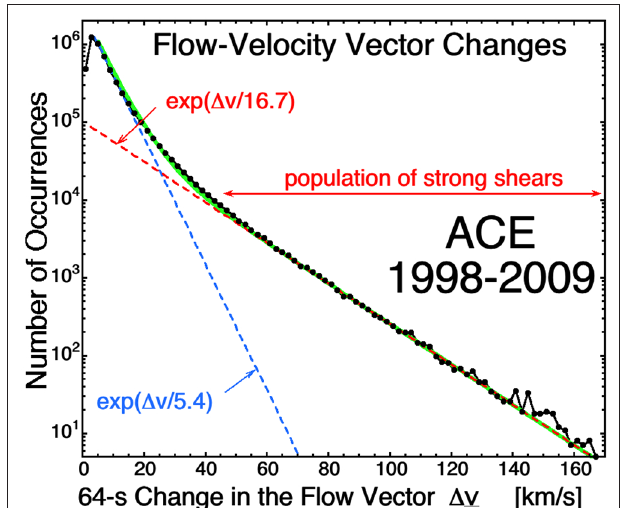
FIGURE 4 | The 64-s change in the solar-wind velocity vector is binned for 11 years of measurements at 1AU by the ACE SWEPAM instrument (McComas et al., 1998 ). The sum of the two exponential fit functions appears in